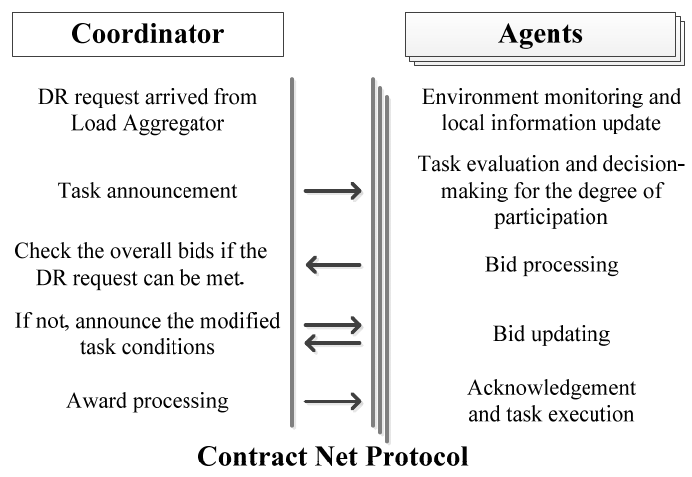
Figure 8. Communication between MGCC and agents using Contract Net